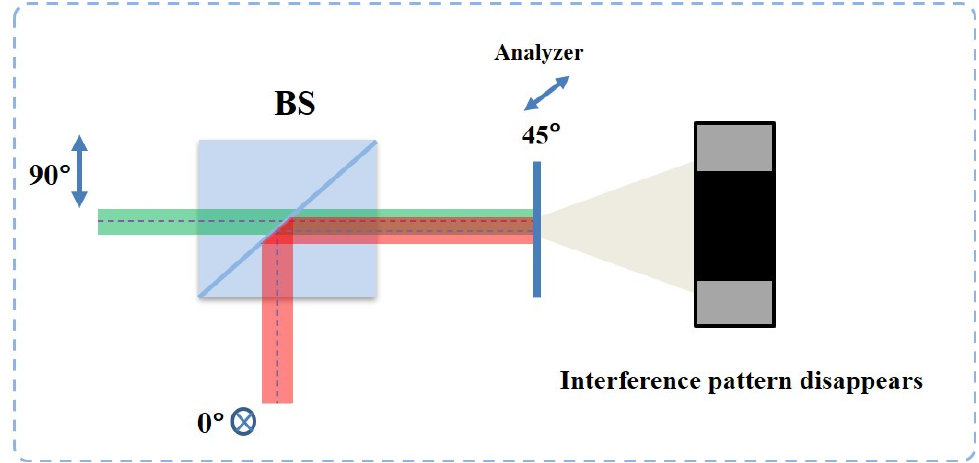
Figure 13. The two orthogonal vector beams are completely parallel after the high-accuracy aligning process and the interference pattern disappears due to the combination of two beams.